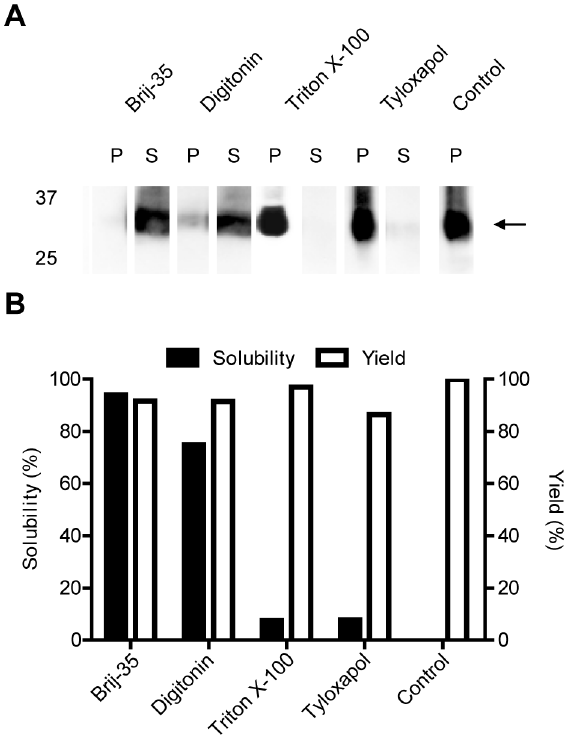
Figure 2. Detergent screening of mAQP4 M23 expressed in the D-CF mode. A: RM samples of 2 m l were analyzed by 16% SDS-PAGE and immunoblotted using anti-His antibodies. B: Solubility of D-CF expressed mAQP4 M23 in presence of 0.2% Brij-35, 0.4% Digitonin, 0.1% Triton X-100, and 0.05% Tyloxapol. Control is P-CF expressed mAQP4 M23. S, supernatant; P, pellet.